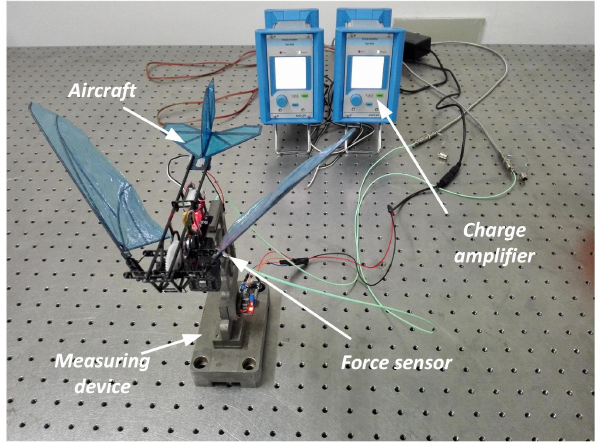
Figure 8. The aircraft and force measurement device in the experi- ment.